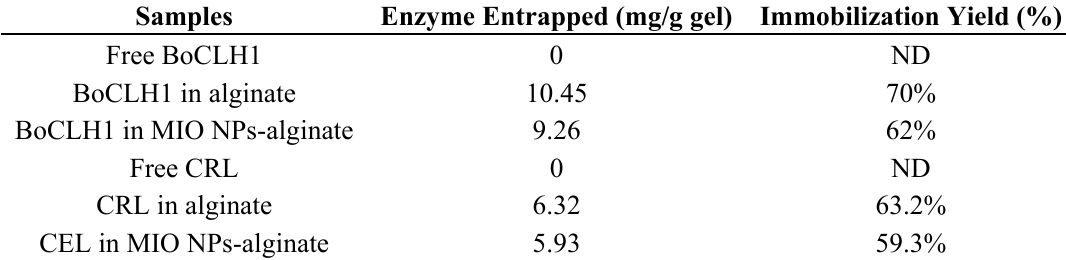
Table 1. Immobilization efficiency of BoCLH1 and CRL entrapped in alginate beads or MIO NPs-alginate beads.